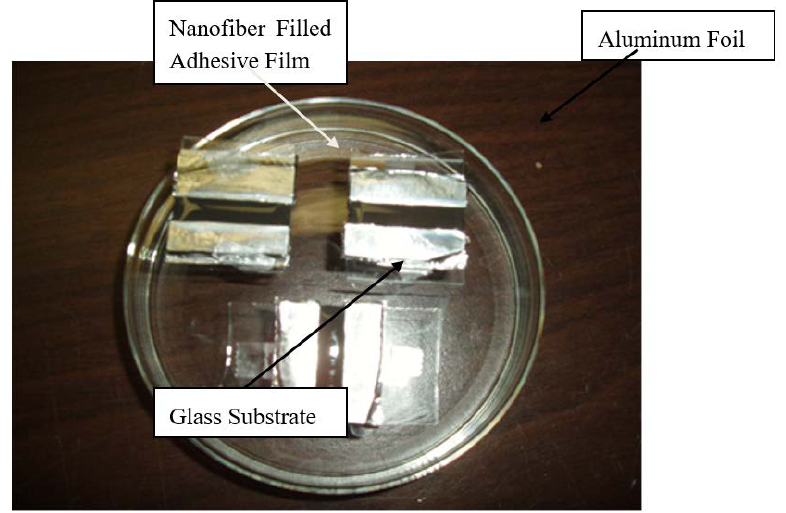
Figure 1. Samples used for the resistance measurement on epoxy adhesive films filled with conductive nanofiber materials.